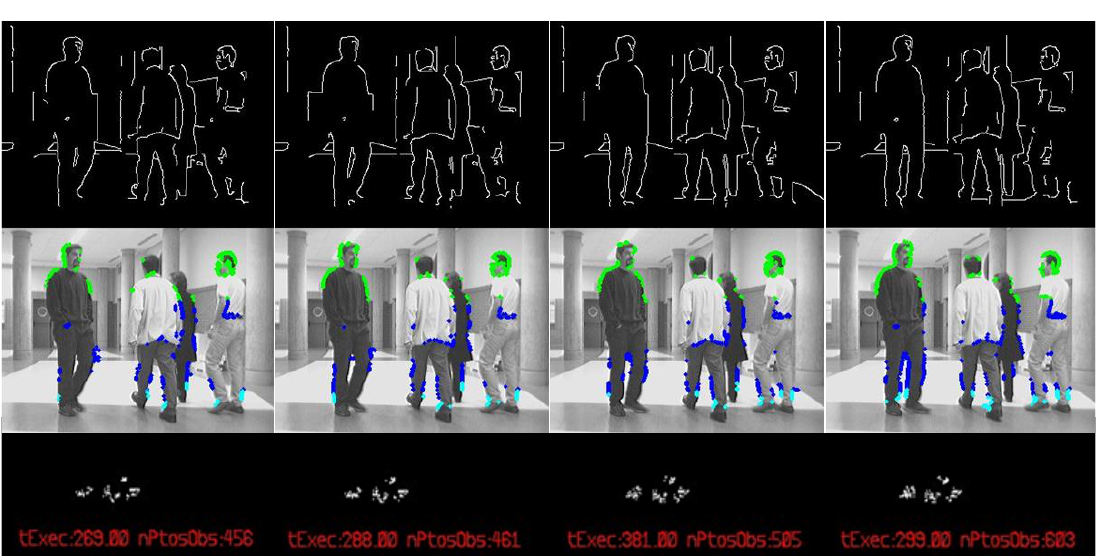
Figure 6. Results of the detection, classification and 3D location process in four frames of a real experiment. Top row, detected edges; middle row, original images; bottom row, 2D ground projection of points classified as